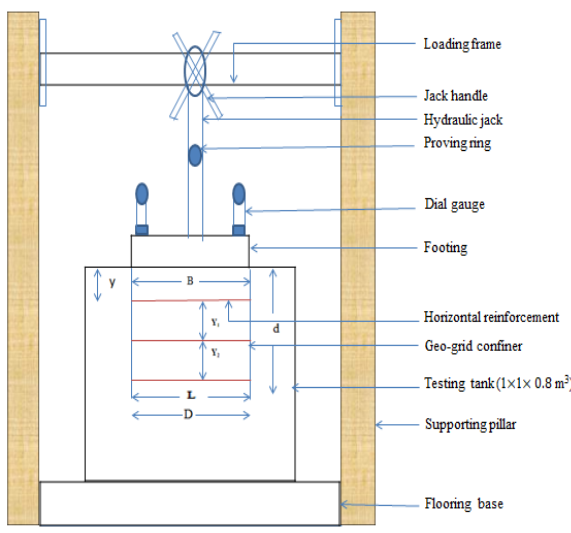
Table 1: Properties of